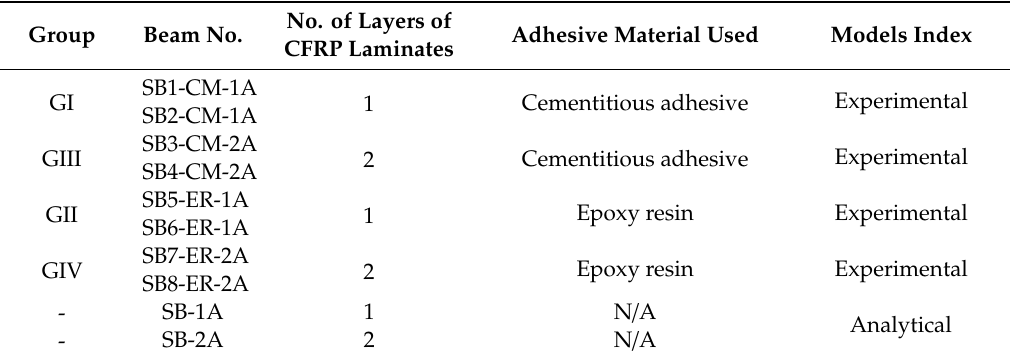
Table 5. Properties of segmental